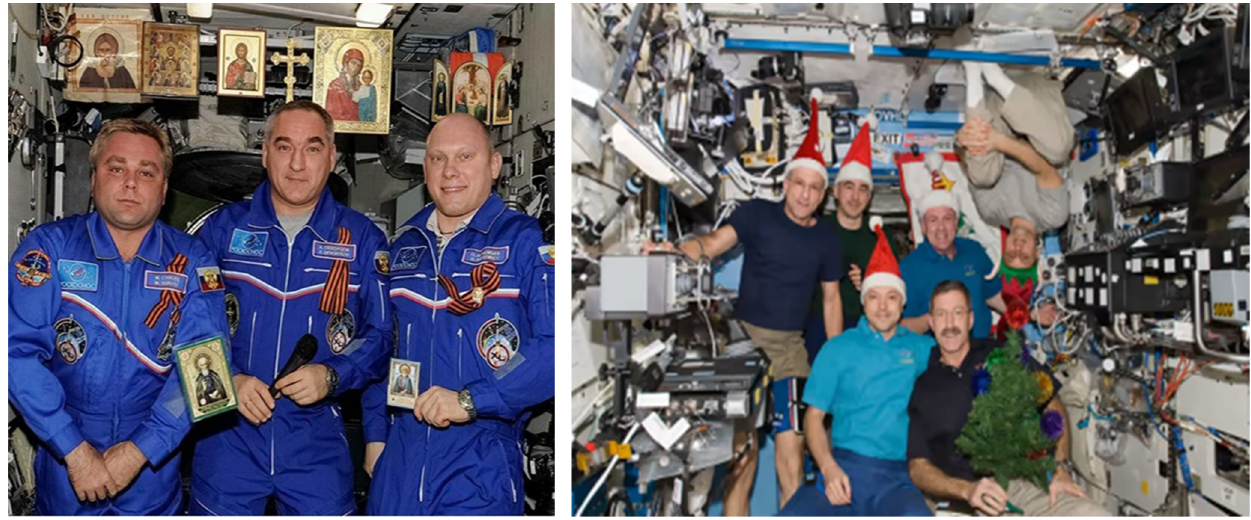
Figure 4. The scenes of Koinonia in space life (Soyuz and NASA), public domain.